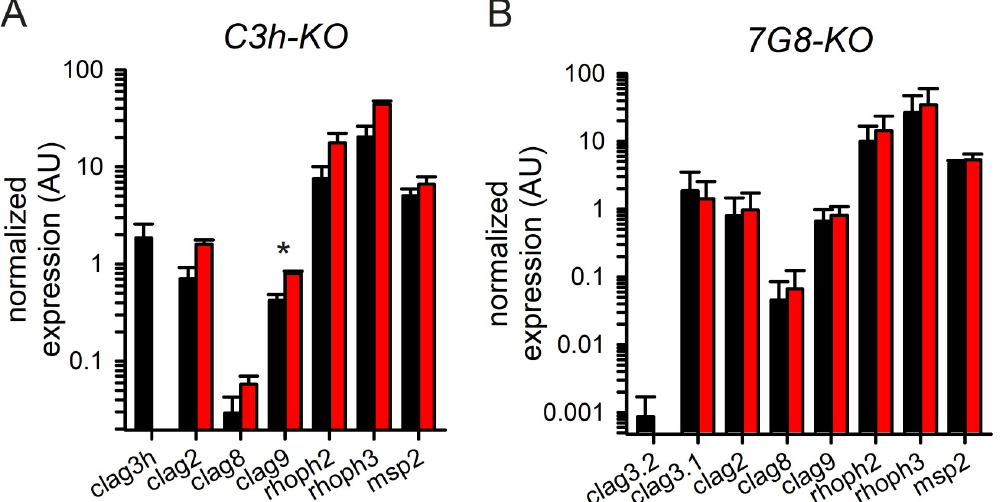
Fig 4. Modest effects on expression of clag paralogs and rhoph genes in the knockout lines. (A) Mean ± S.E.M. normalized expression of clag and rhoph genes in KC5 and C3h-KO (black and red bars, respectively; n = 3), calculated according to 2 - Δ Ct using PF07_0073 as an internal control. Only clag9 exhibited a statistically significant upregulation in the Ch3-KO knockout (asterisk, P = 0.007). (B) Insignificant changes in expression of these genes in the 7G8-KO knockout when compared to 7G8 (red and black bars, respectively; n = 2–3 for each gene). The msp2 control exhibits stage-specific transcription similar to clag and rhoph genes, and is not affected in these knockout lines.